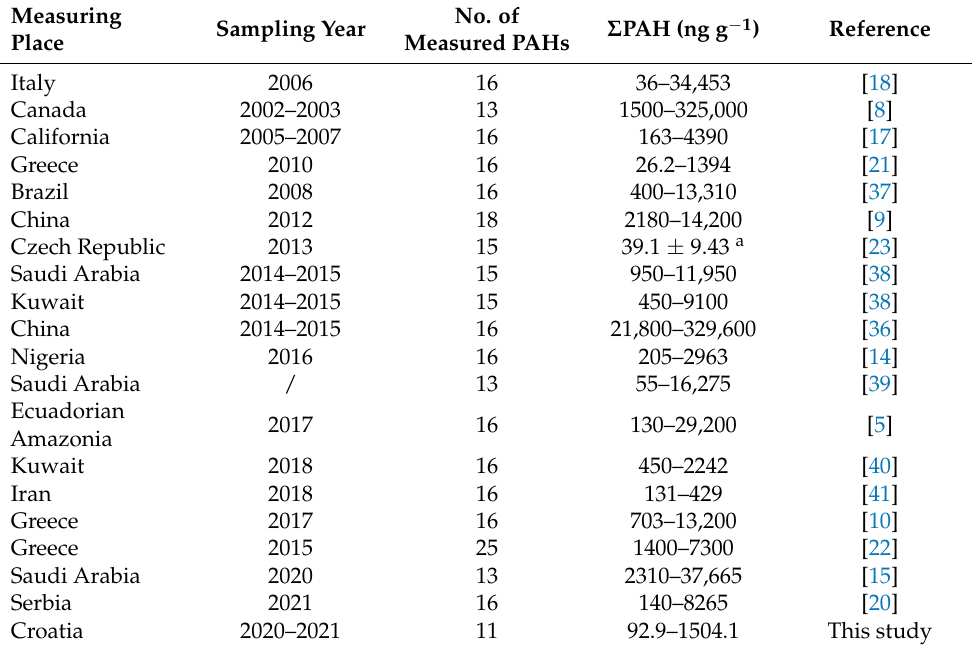
Table 2. Mass fraction ranges of PAHs in house dust samples from residential indoor environments around the world (ng g − 1